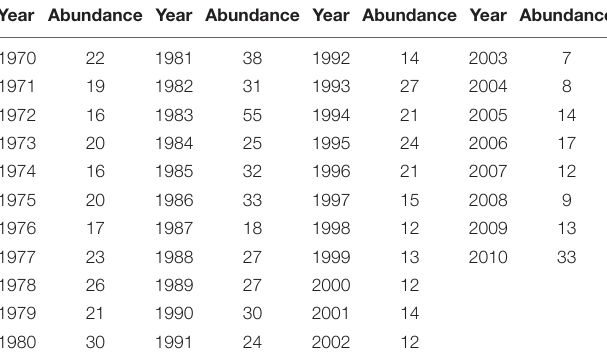
TABLE 2 | Annual average abundance of Atlantic cod at site 119.